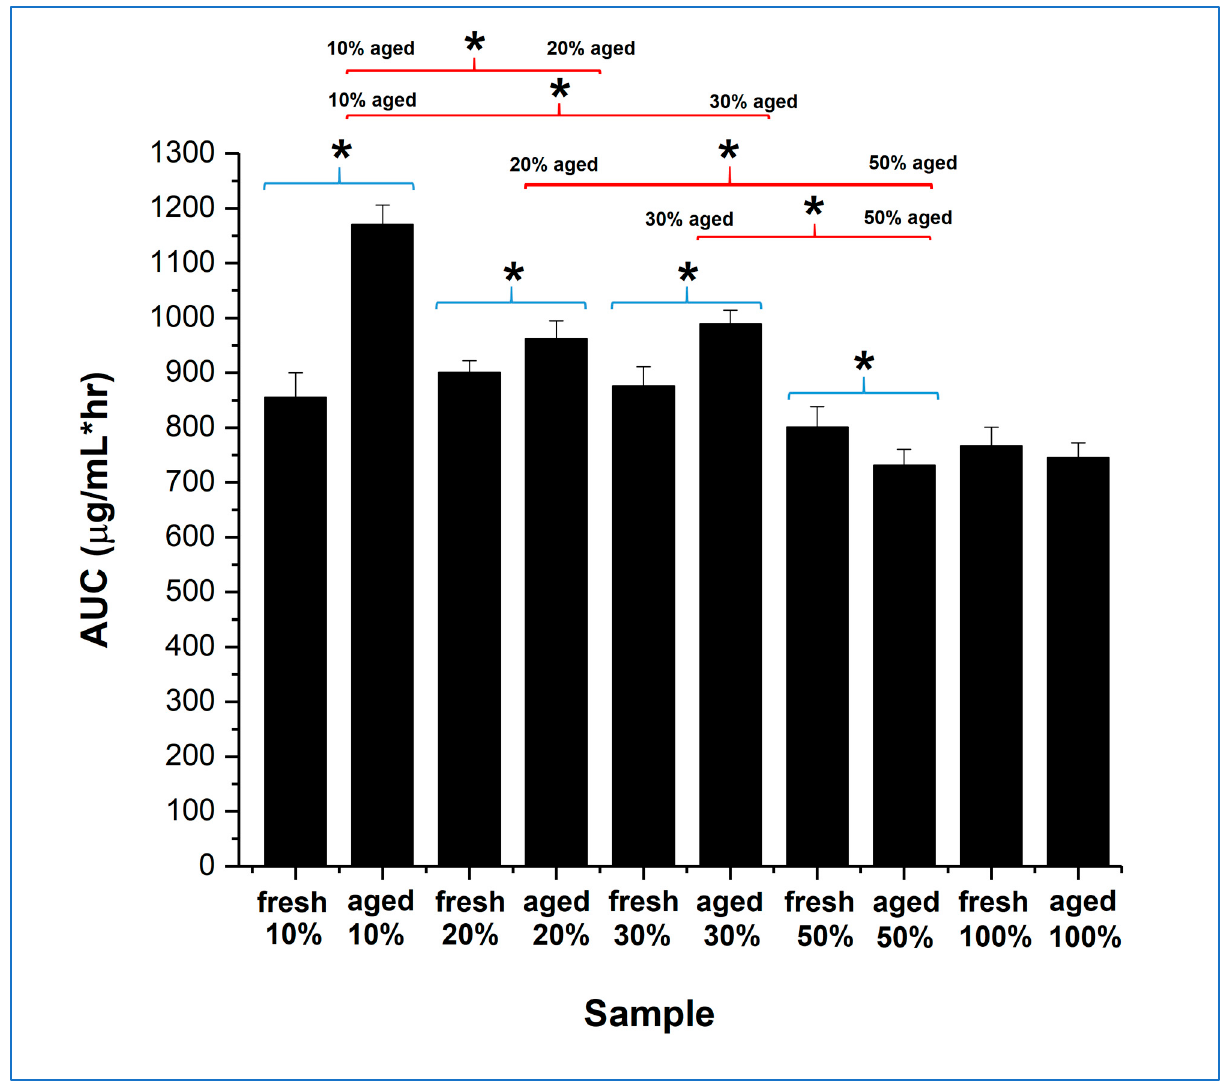
Figure 8. Overall (24 hours) AUC of the dissolution–supersaturation profiles obtained under non-sink conditions for itraconazole-loaded sucrose microfibres (containing 20, 30, and 50% w / w itraconazole) and pure itraconazole microfibres, both freshly prepared and after 30 days exposure to 25 °C/75% RH (aged). * with blue brackets indicates a significant difference ( p < 0.05) between fresh and aged samples of the same formulation. * with red brackets indicates a significant difference ( p < 0.05) between different aged formulations.